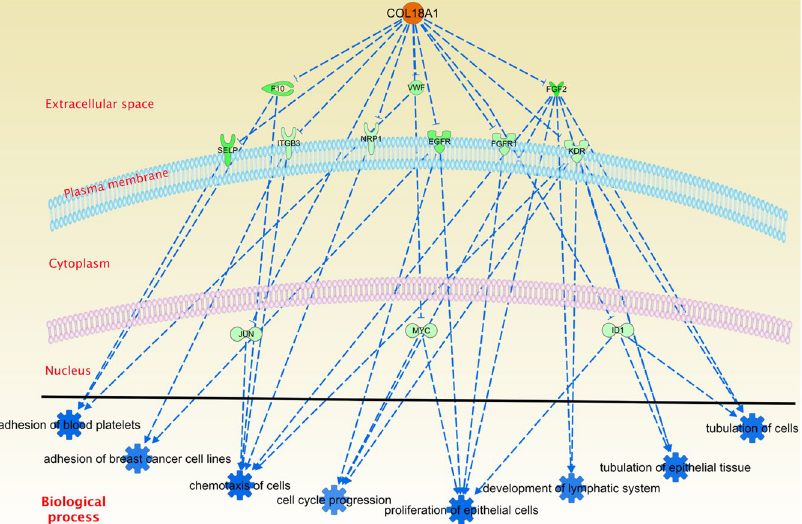
Figure 6. Upstream regulator analysis for COL18A1. COL18A1 overexpression (orange) decreases the expression of all molecules present in the figure (green), which accounts for the inhibition (dashed blue lines) of the biological processes indicated